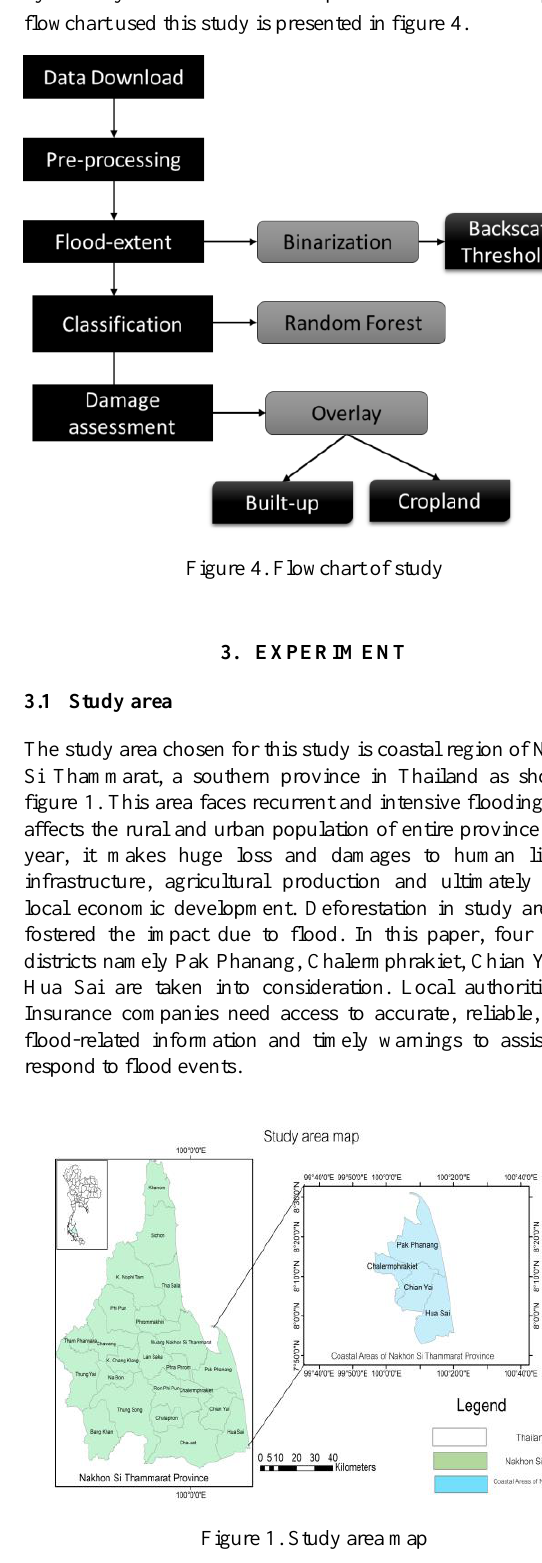
Figure 3. Pre-processed Sentineil-1 data in VV polarization